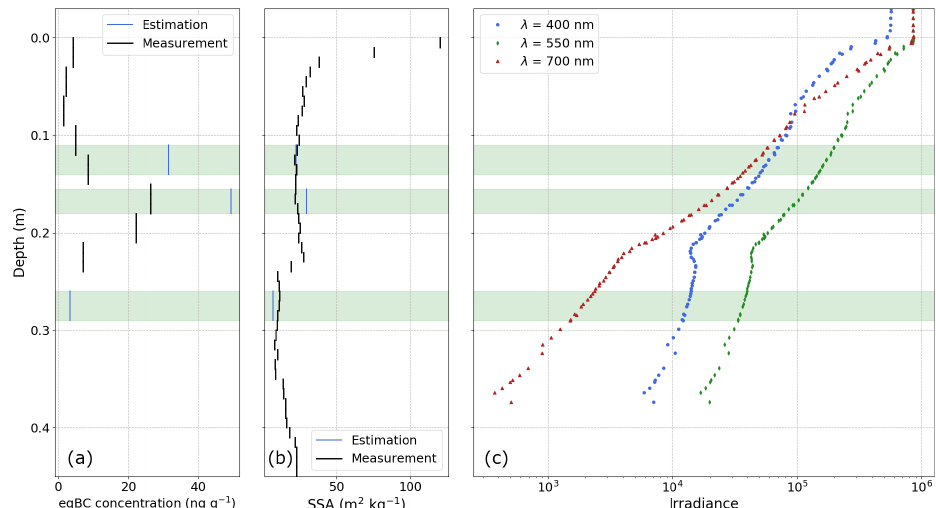
Figure 6. Comparison between snow pit measurements and estimated SSA and LAP concentrations for the SOLEXS profile 002 on 13 Febru- ary 2018; green shading corresponds to the different ZOIs of the profile. (a) Vertical profile of eqBC concentration, measured (black) and estimated from AFEC optimisation on each ZOI (blue). (b) Vertical profiles of SSA, measured (black) and estimated from AFEC optimisation on each ZOI (blue). (c) SIP measurement from which AFEC has been